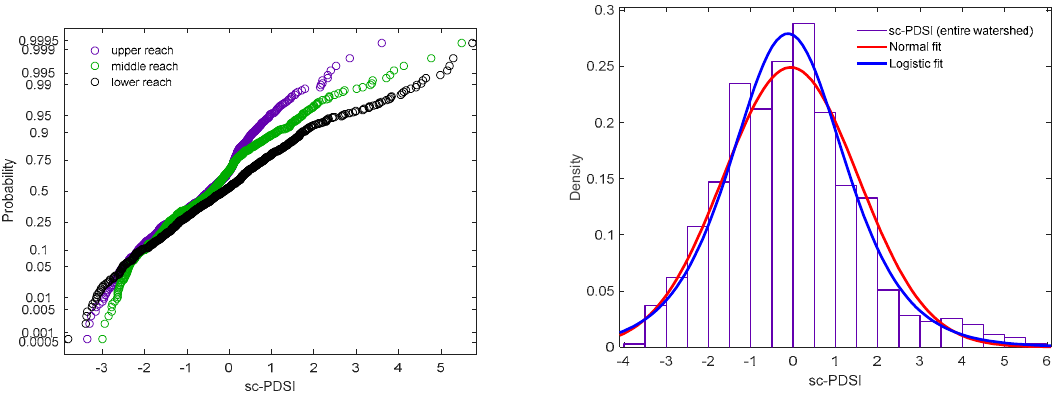
Figure 6. Probability density of sc-PDSI in YRB on the monthly scale from 1951 to 2017. 4.4. Impacts of Key Hydrological Cycle Elements on Drought at Different Time Scales P, ET 0 , and AET were key hydrological cycle elements that promote the development of the hydrological cycle, which had a great impact on drought in the basin. P, ET 0 , and AET showed a significant correlation with sc-PDSI at different time scales in the YRB (Table